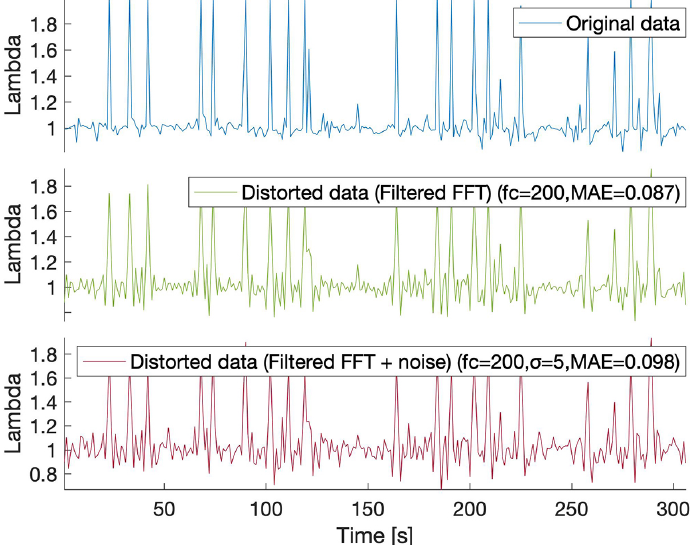
Figure 3. 2D FFT-based data distortion for the Lambda sensor data ( f c -cut-off frequency, σ -discord, MAE -Mean Absolute Error): original data values ( blue ), filtered values in frequency domain ( green ), filtered and perturbed values in the frequency domain using additive Gaussian noise ( red